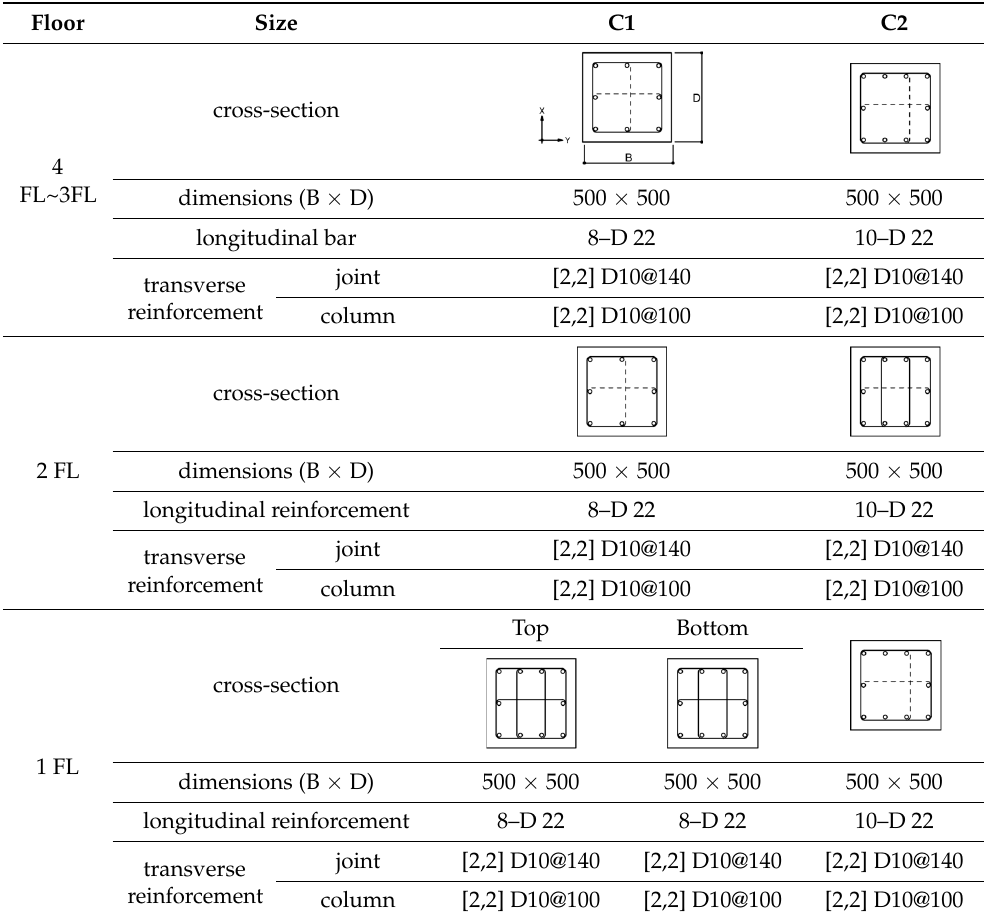
Table 3. Cross-sections and reinforcement details of exterior and interior beams.